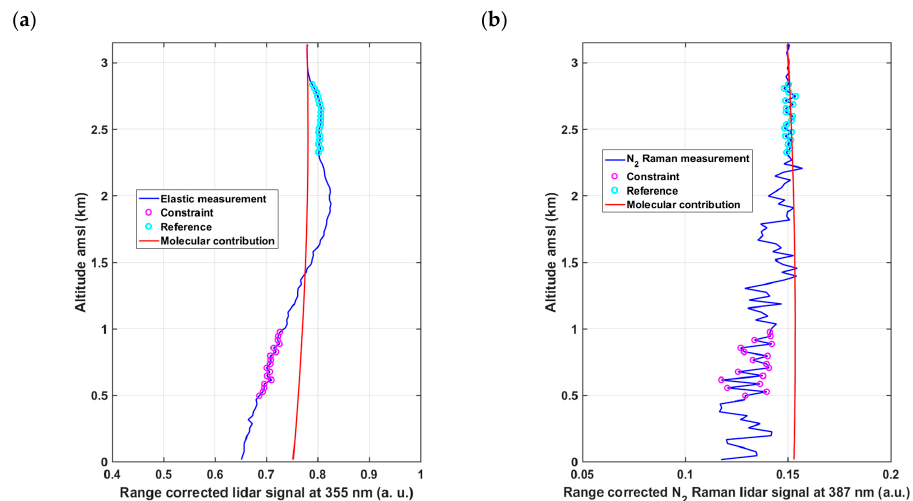
Figure 10. Example of random draws used for the Monte Carlo approach for: ( a ) the elastic channel and ( b ) the N 2 -Raman channel. The reference altitude interval (2.35–2.85 km amsl) is given by turquoise circles and the constraint altitude interval (0.5–1 km amsl) is given by purple circles. A purely molecular Lidar signal is drawn as a continuous red line.